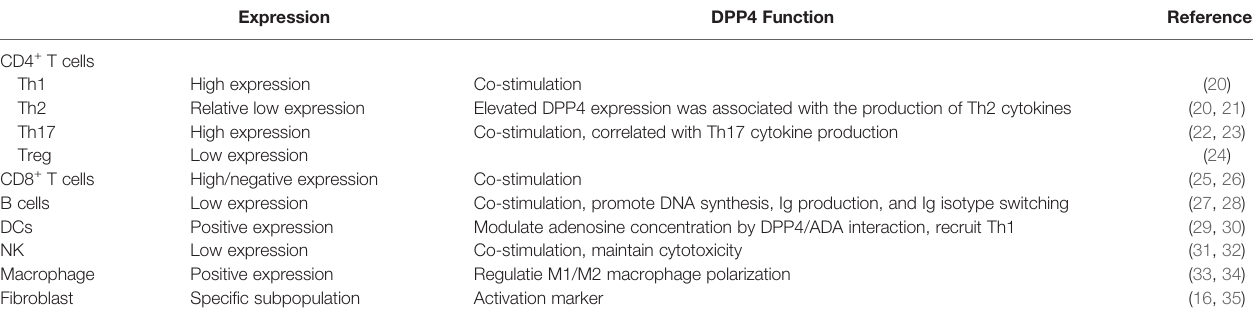
TABLE 1 | The expression and function of DPP4 in immune